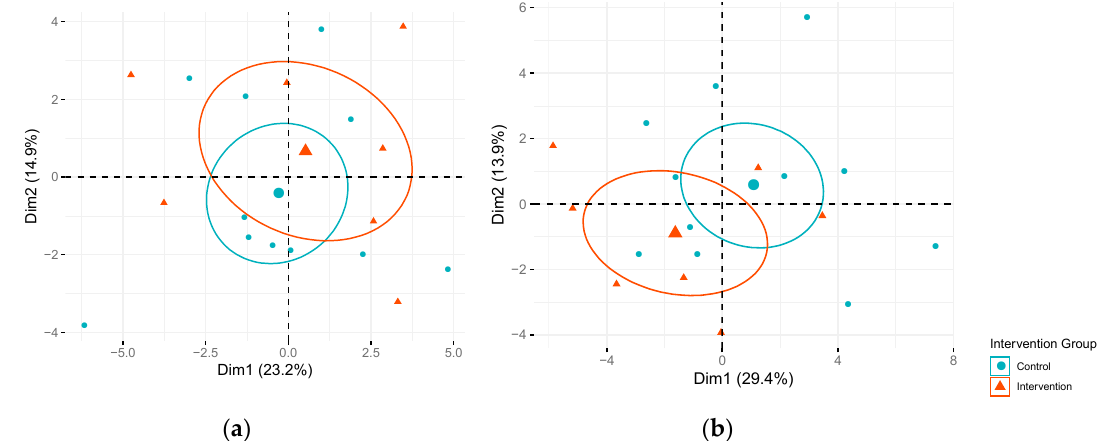
Figure 1. Score plot of principal component (PC) 1 versus PC2 by intervention arm. Fasting metabolites in intervention and control arms among Pregnancy and EARly Lifestyle improvement Study (PEARLS) participants: ( a ) during early ( n = 29) and ( b ) mid-pregnancy ( n = 18). Dimension 1 (Dim1) represents PC1 and Dimension 2 (Dim2) represents PC2. Percentage of variation in fasting metabolite levels explained by each PC is presented in parentheses. Ellipses represent 95% confidence ellipses by intervention group and larger symbols represent the center of the ellipse.